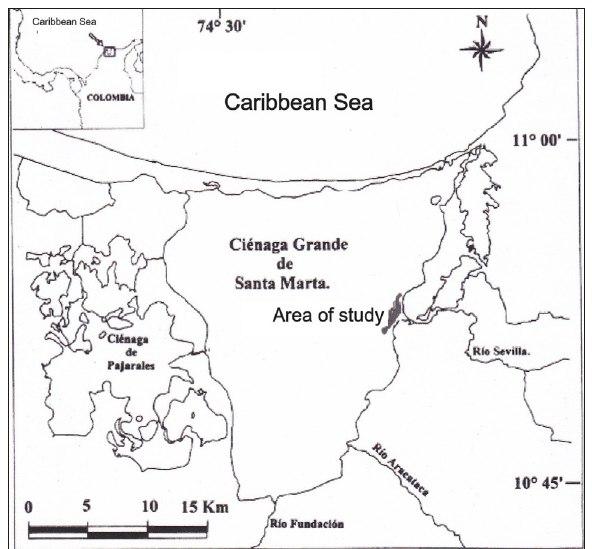
Figure 1. Map of Ciénaga Grande de Santa